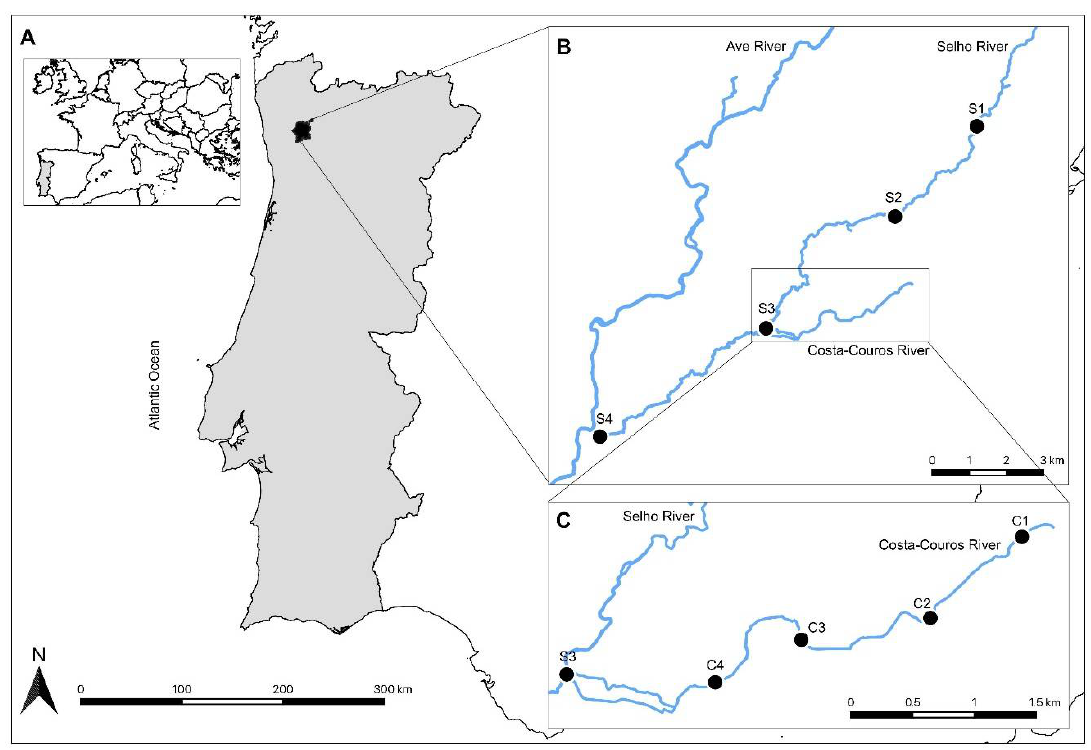
Figure 1. Geographical situation. ( A ) Location of the study area (Guimarães municipality; filled in black) in Portugal mainland. Location of the sampling sites of the ( B ) Selho river (S1 to S4) and ( C ) Costa-Couros river (C1 to C4).